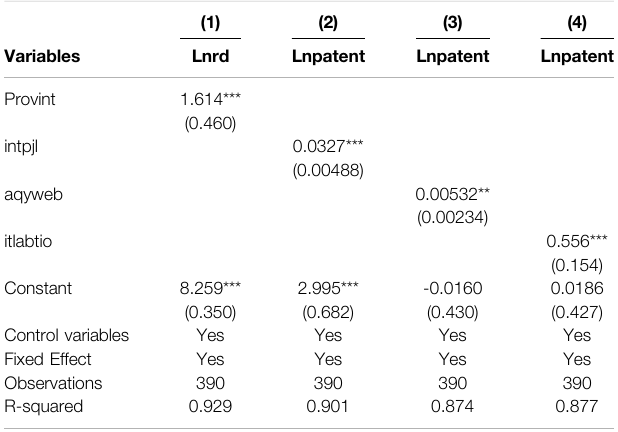
TABLE 9 | Robustness tests of alternative explanatory variables and explained variables.